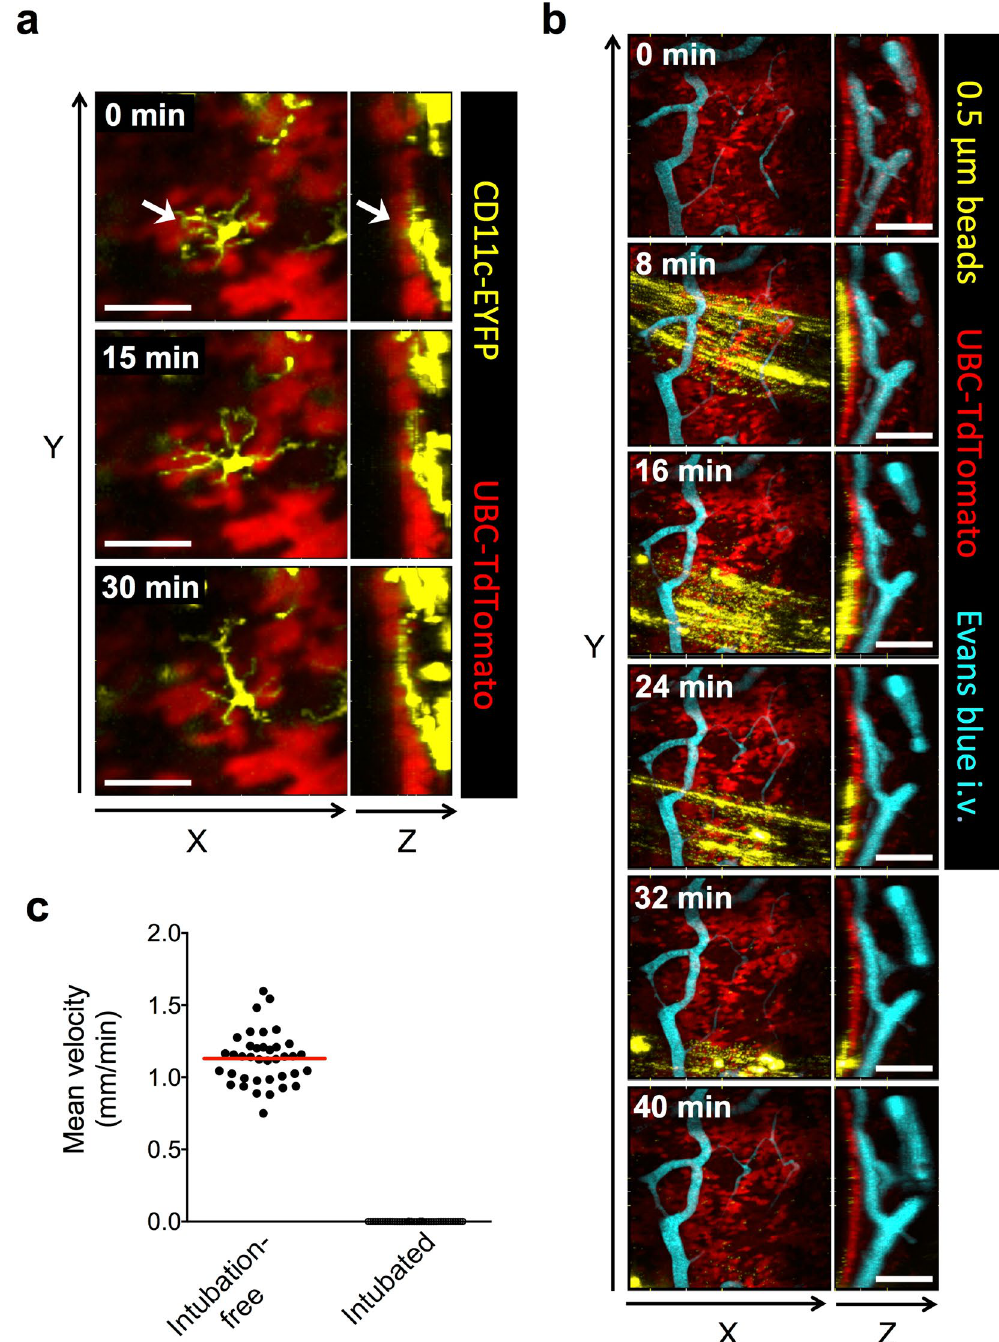
Figure 3. Visualizing IE-DC probing behavior and mucociliary clearance in the steady-state. ( a ) IE-DCs were visualized in CD11c-EYFP x UBC-TdTomato mice using the intubation-free setup. Snapshots from Supplementary Video 9 are shown as XY and ZY representations, bar = 50 µ m. Arrows indicate an IE-DC. ( b ) Yellow/green fluorescent 0.5 µ m polystyrene beads were o.ph. delivered to UBC-TdTomato mice and the tracheal mucosa was visualized using the intubation-free setup. Evans blue was injected i.v. via a tail vein catheter to visualize blood vessels. Snapshots from Supplementary Video 10 are shown as XY and ZY representations, bar = 100 µ m. ( c ) The mean velocities of bead aggregates with an approximate size of 10 µ m were determined from single-plane video-rate movies (such as the one shown in Supplementary Video 12). Each dot represents the velocity of a single bead aggregate; horizontal red line indicates mean value. Data were pooled from the analysis of 2